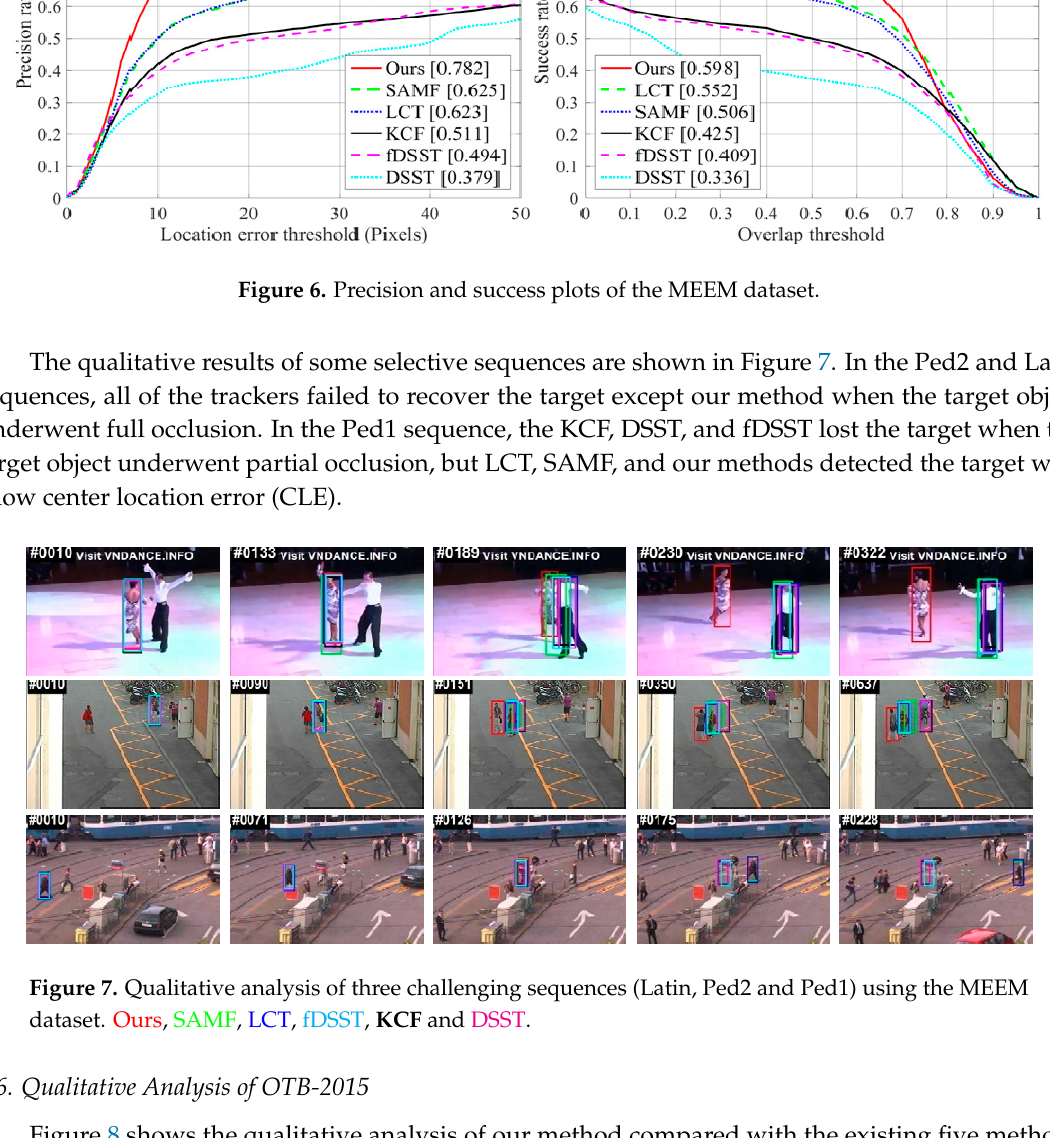
Figure 8. Qualitative results of six trackers: Ours, MUSTer, SAMF, DSST, KCF and TLD.